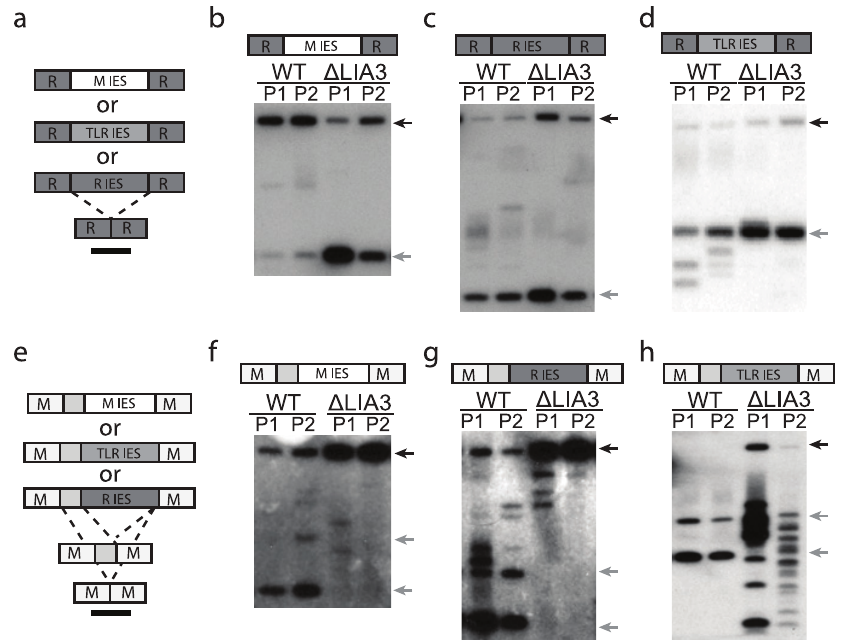
Fig 3. Lia3 acts on the flanking region of the M IES. (a and e) Schematic of the expected rearrangement in wt cells of chimeric IESs used in the Southern blots shown in b, c, e, and f. Boxes labeled M or R represent the flanking DNA of the M IES or R IES; light grey boxes, the 0.3kb internal region of the M IES; box labeleled M IES or R IES or TLR IES, the indicated germline-limited sequence; black bar, Southern probe (b-d, f-h). Each lane of the Southern blot contains genomic DNA isolated from three co-cultured transformants. The diagram above each Southern blot denotes which chimeric IES-rDNA vector was introduced into mating cells. Black arrows indicate the position of the unrearranged DNA, while grey arrows point to fragments of the size expected after accurate IES excision.